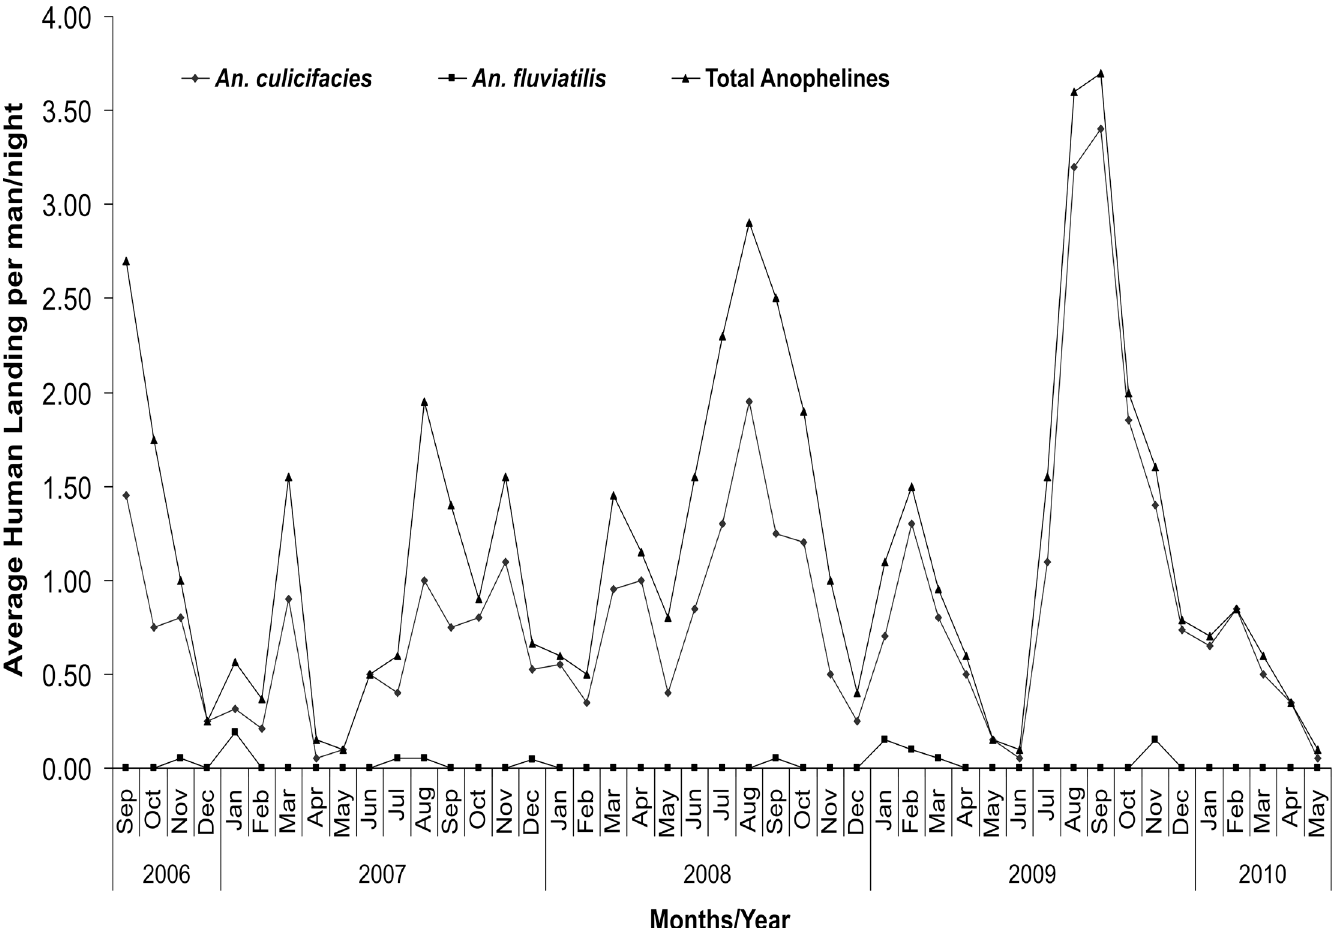
Fig 5. Month/Year wise per man per night catches in study villages of district